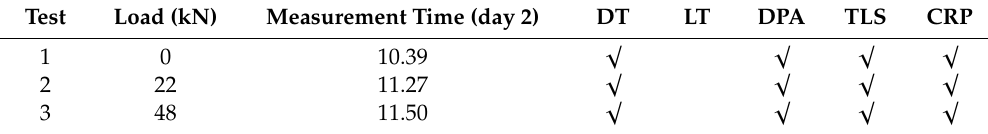
Table 2. Plan of the performed measurements beam#1 second load condition (LC2).